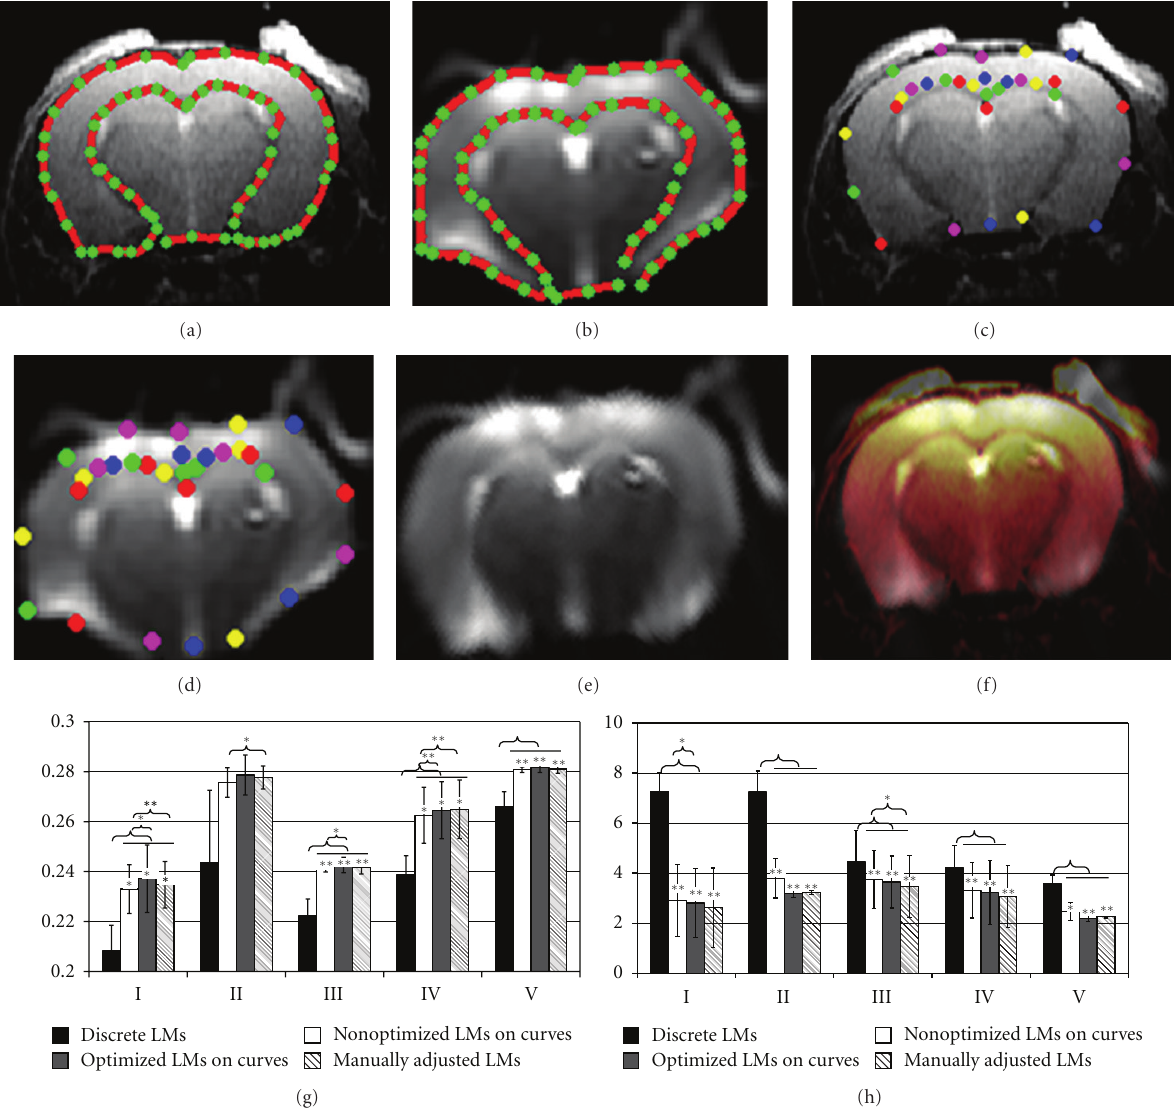
Figure 3: The correction of the geometrical distortion on a B0 image (a) in EPI DTI employing the T2-wt image (b) as the reference by optimized landmarks on curves (a) and (b), and manually selected discrete landmarks (c) and (d). The colors of homologous landmarks are matched in (c) and (d). The B0 image transformed using the thin-plate splines with optimized landmarks in (a) and (b) is shown in (e), and overlaid on the T2-wt image plotted in pseudocolor (f). The average NMI and TRE of corrected B0 and T2-wt images in five image pairs (I–V) were shown in (g) and (h), respectively. NMI and TRE were calculated on the B0 images transformed using manually selected “discrete landmarks (LMs)” (black columns), landmarks generated on curves but not optimized (“Nonoptimized LMs on curves”) (white columns), curve landmarks optimized using (1) (“Optimized LMs on curves”) (gray columns), and curve landmarks manually refined (“Manually adjusted LMs”) (stripped columns) ∗ : P < 0.1; ∗∗ : P <